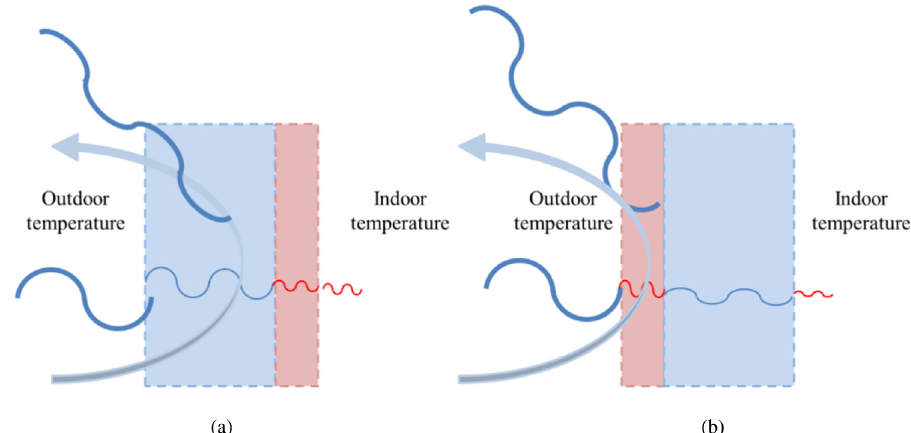
Fig. 5. Graphical representation of the cushioning effect of the thermal wave which produces each facade. (a) Indoor insulation and outdoor thermal mass. (b) Outdoor insulation and indoor thermal mass.